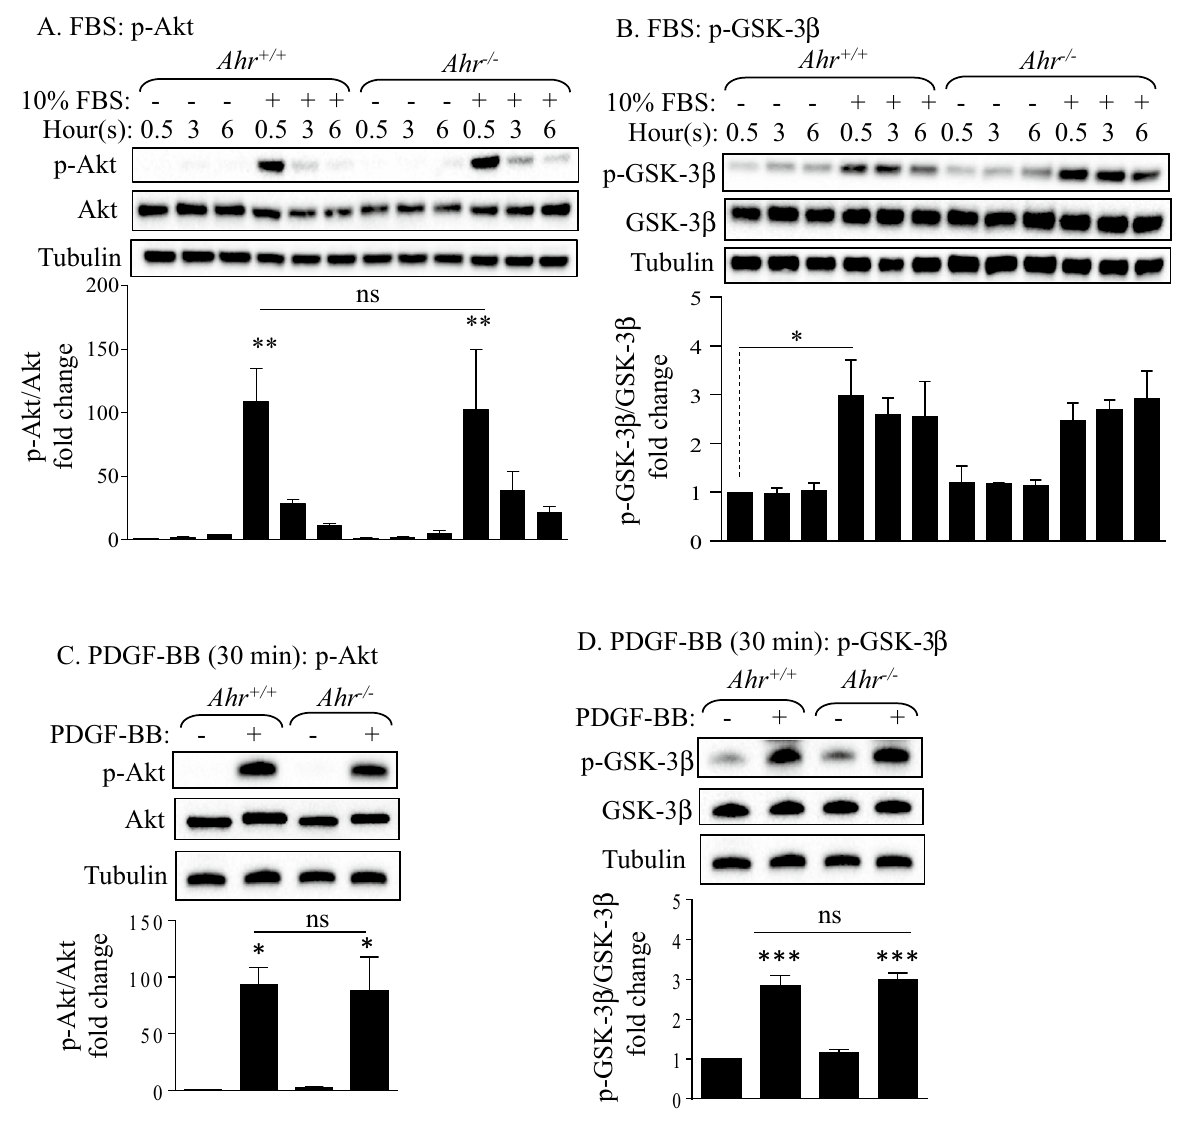
Figure 1. Effect of AhR expression on Akt and GSK-3β phosphorylation in MLFs exposed to 10% FBS or PDGF-BB. ( A , B ) Ahr +/+ and Ahr −/− MLFs were either serum-starved for 18 h or maintained in 10% FBS. Cellular protein was extracted after 0.5, 3 and 6 h of changing either the serum-free or 10% FBS containing medium for Western blot analysis of ( A ) Akt and ( B ) GSK-3β phosphorylation. ( C , D ) Serum-starved Ahr +/+ and Ahr −/− MLFs were treated with or without 20 ng/ml of PDGF-BB for 30 min and cellular protein was extracted for Western blot analysis of ( C ) Akt and ( D ) GSK-3β phosphorylation. Depicted blots are representative of three independent experiments. Densitometric values of the phosphorylated proteins were normalized to the values of their corresponding total proteins and were converted to fold changes relative to that of the control Ahr +/+ cells. Results are expressed as mean ± SEM (*p < 0.05; **p < 0.01; ***p < 0.001; ns, not statistically